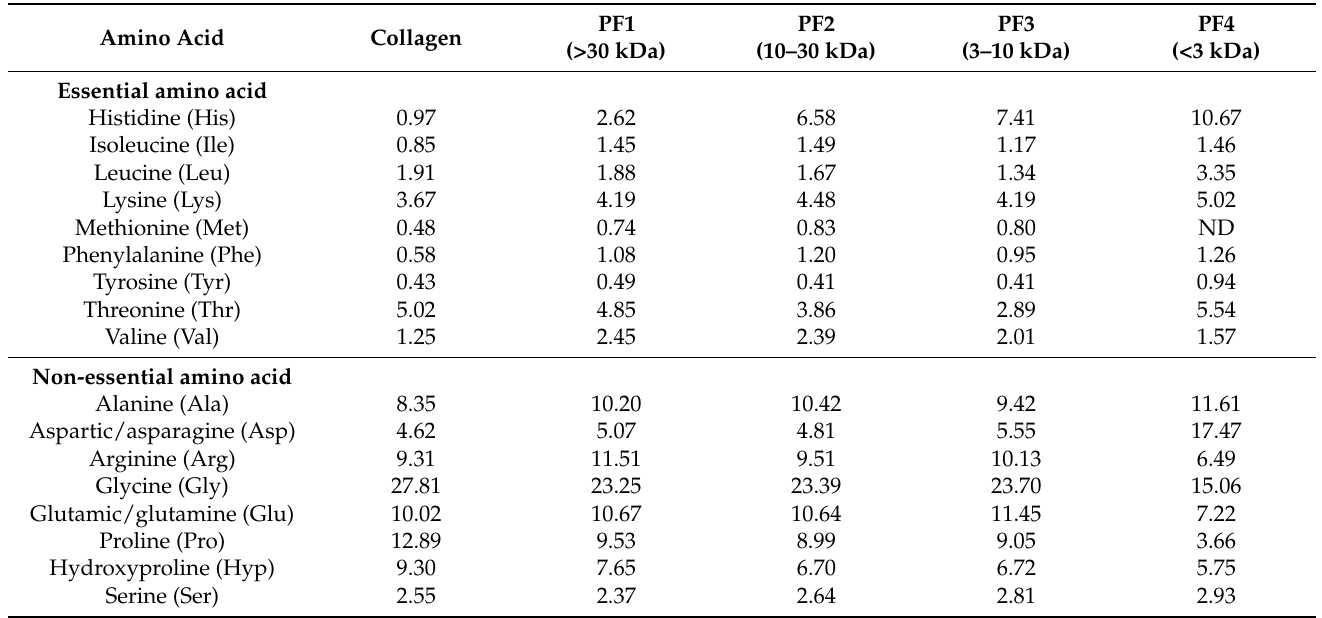
Table 1. Amino acid composition (expressed as % of total amino acids) of extracted collagen and peptide fractions.